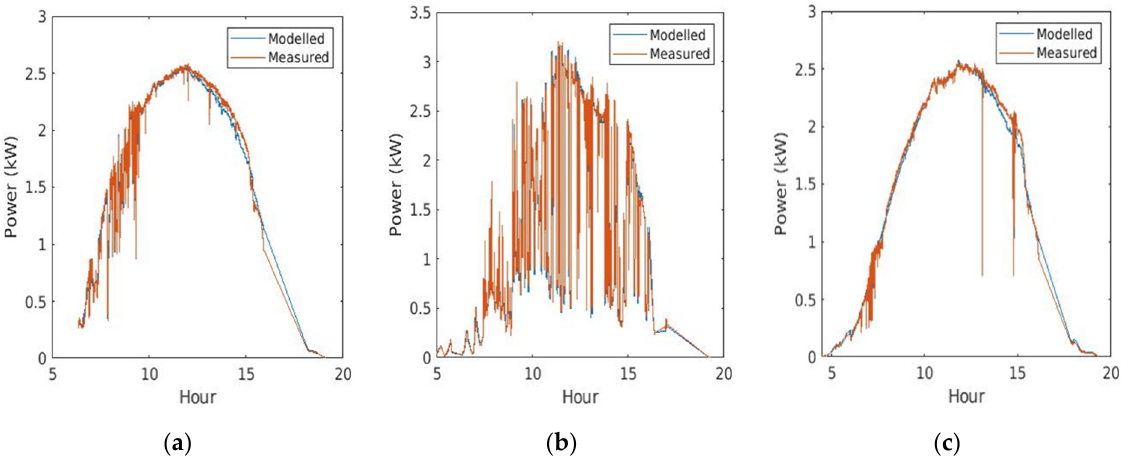
Figure 8. Comparison between the measured values of PV power with respect to values obtained from the conversion of real GHI measurements at the site. The selected days are: ( a ) a partially cloudy day (17 May 2021: 𝑟𝑀𝐴𝐸 = 3.04% 𝑟𝑅𝑀𝑆𝐸 = 3.90% ), ( b ) an overcast day (1 June 2021: 𝑟𝑀𝐴𝐸 = 4.03% 𝑟𝑅𝑀𝑆𝐸 = 5.95% ) and ( c ) a sunny day (4 June 2021: 𝑟𝑀𝐴𝐸 = 2.54% 𝑟𝑅𝑀𝑆𝐸 = 3.44% ).